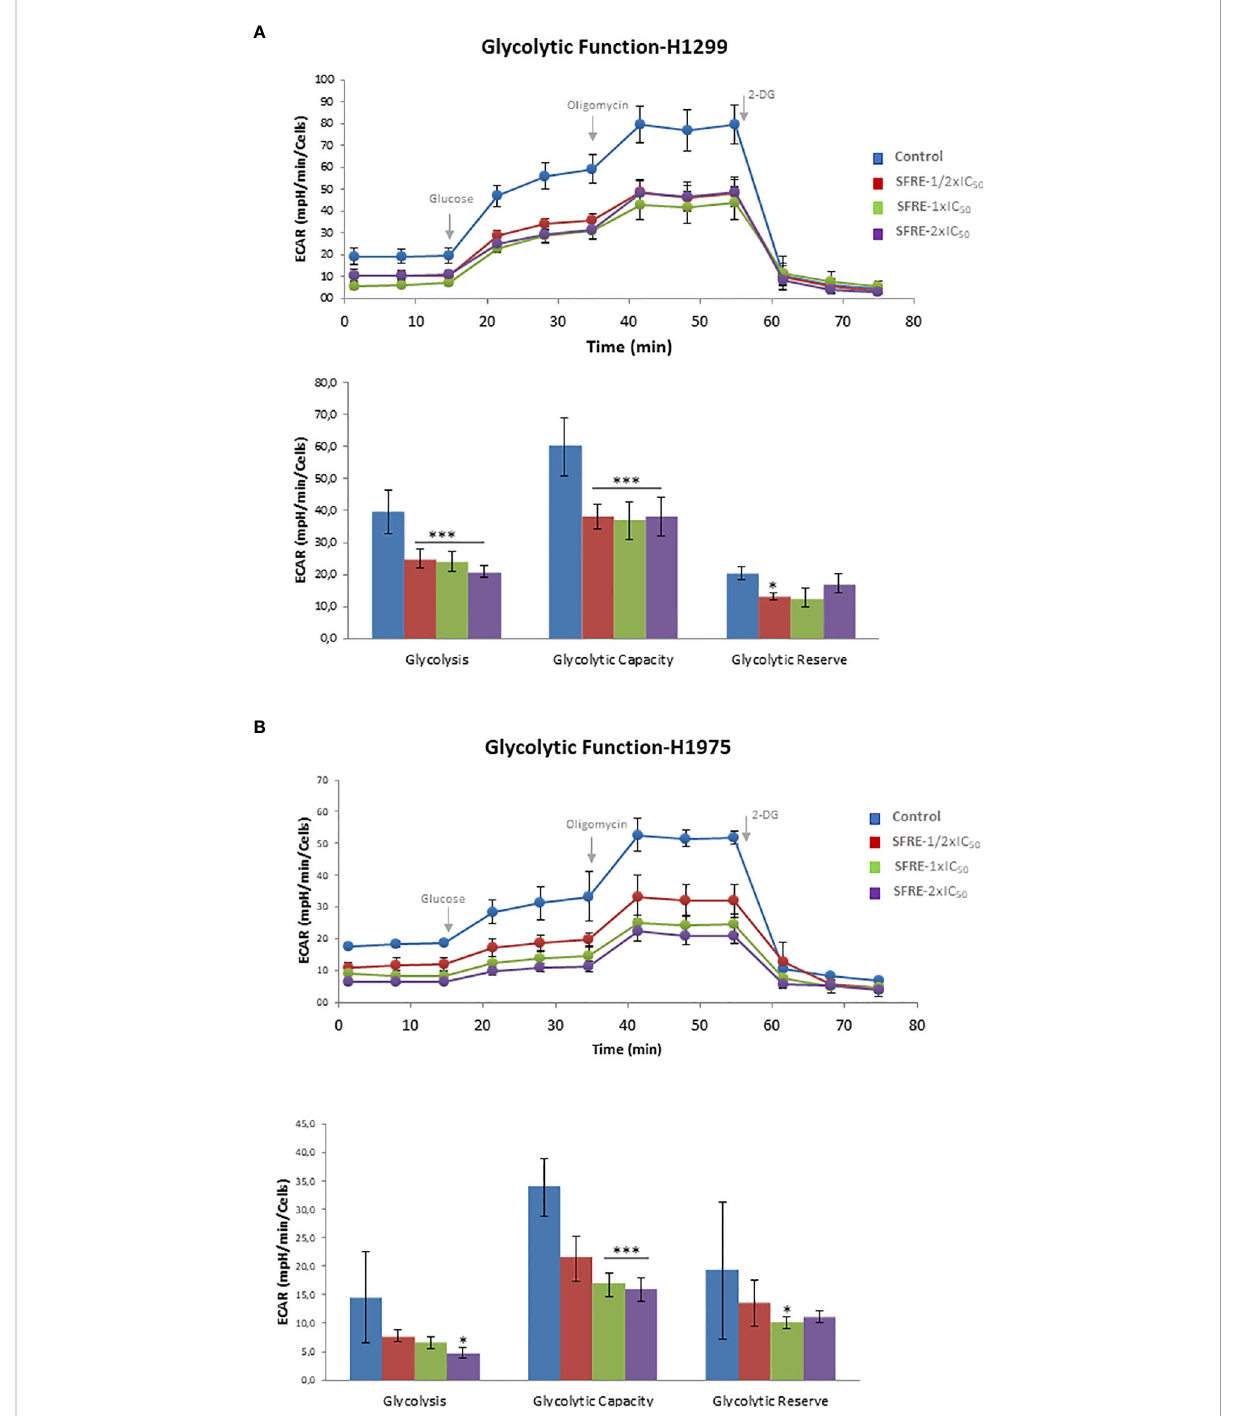
FIGURE 2 SFRE diminishes aerobic glycolysis. Aerobic glycolysis analysis by the fl ux analysis of the extracellular acidi fi cation rate (ECAR) of H1299 cells (A) and H1975 (B) , previously pre-treated with SFRE at three doses (1/2xIC 50 , 1xIC 50 and 2xIC 50 ) for 48 h The basal ECAR, glycolysis and maximal ECAR of 10,000 cells per condition are compared. Data represent mean ± SEM of three independent experiments, each performed four to six replicates. Asterisks *, *** indicate p-values < 0.05, and 0.005,